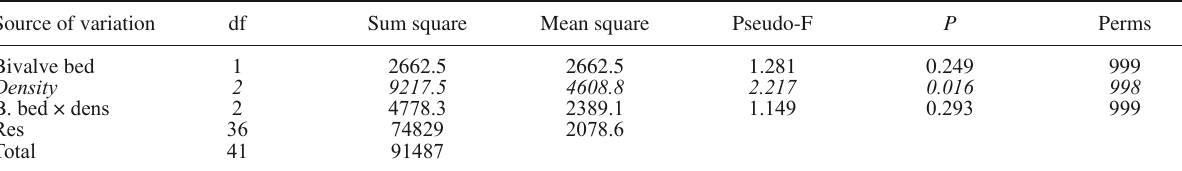
Table 4. – PERMANOVA of decapod assemblages related to species bed and density. Italics denote significant differences. Source of variation df Sum square Mean square Pseudo-F P Perms Bivalve bed 1 2662.5